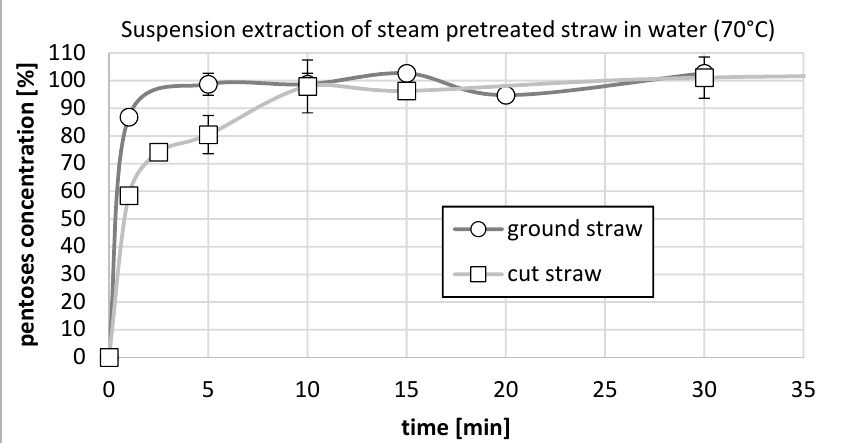
Figure 3. Dimensionless concentration of total pentoses of a suspension extraction of steam pretreated wheat straw (180 °C, 35 min) in a stirred tank. Solid lines are shown for visual orientation only. The difference between the two shown samples was the particle size. The ground particles reached 87% of the equilibrium after one minute, while 58% was reached for the larger particles. The ground and coarse samples reached an equilibrium between 1 and 5 min and between 5 and 10 min,